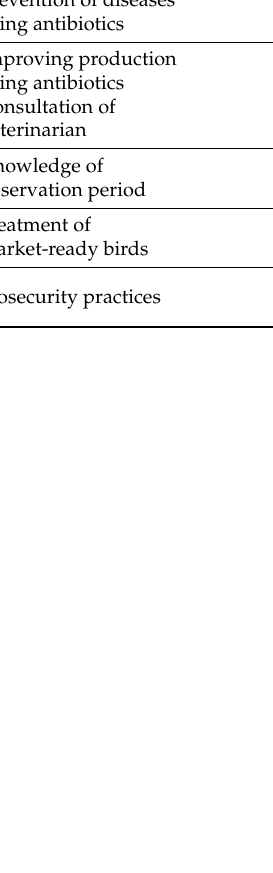
Table 2. Multivariable logistic regression model of factors associated with AMR